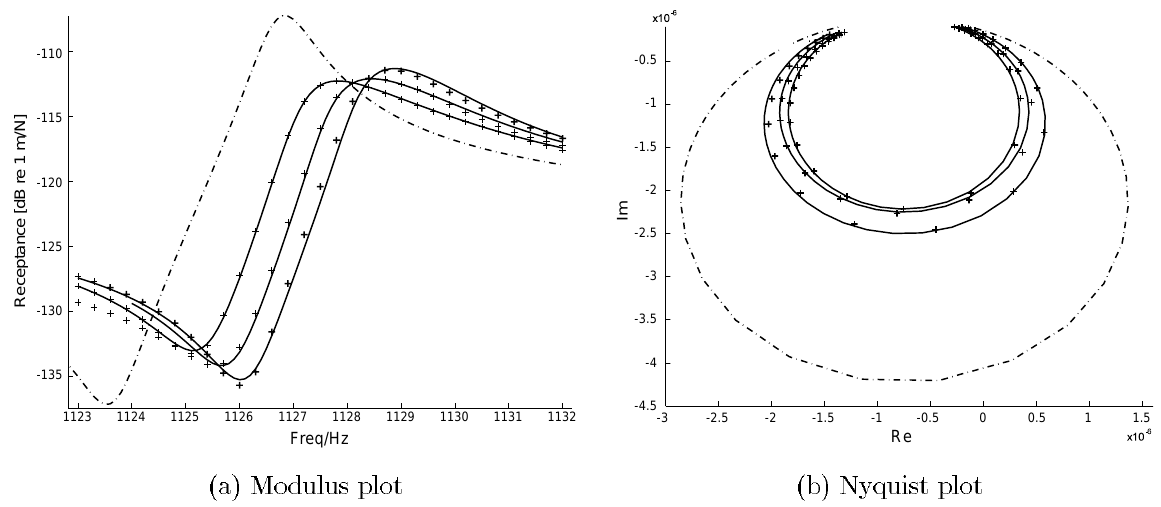
Fig. 15. Predictions with assumed linear model: ... Linear response, HBM simulations, *****